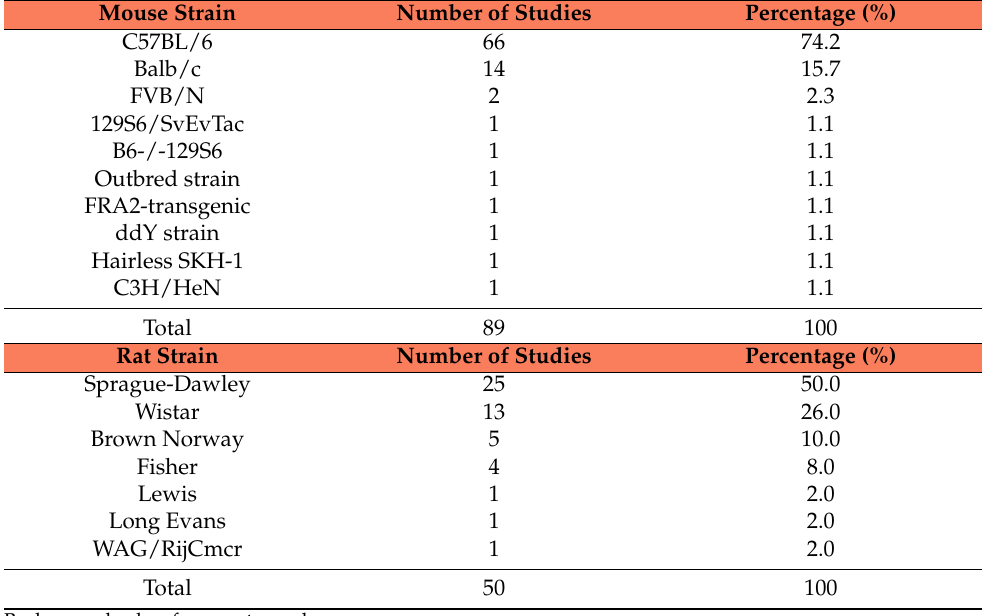
Figure 3. Animal species that were used for in vivo models to create lung injury. Mouse and rat models were the most abundantly used animals. Table 1. The most frequently used strains from the mouse and rat studies.